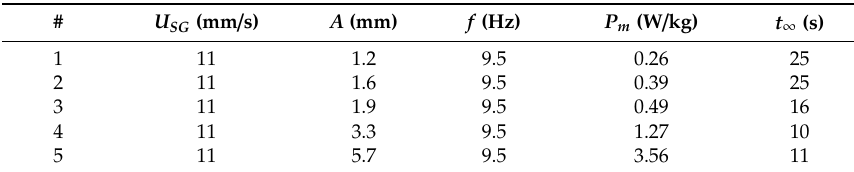
Figure 14. Effect of vibration amplitude on mixing time with f = 9.5 Hz and U SG = 11 mm/s. Figure 14. E ff ect of vibration amplitude on mixing time with f = 9.5 Hz and U SG = 11 mm / s. Table 4. Operation settings used to study the e ff ect of vibration amplitude on mixing time and the resulting mixing